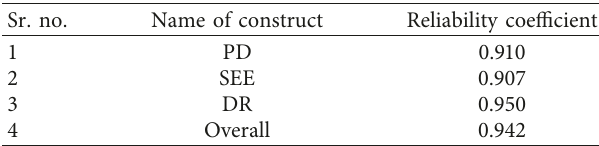
Table 4: Reliability analysis. Sr.